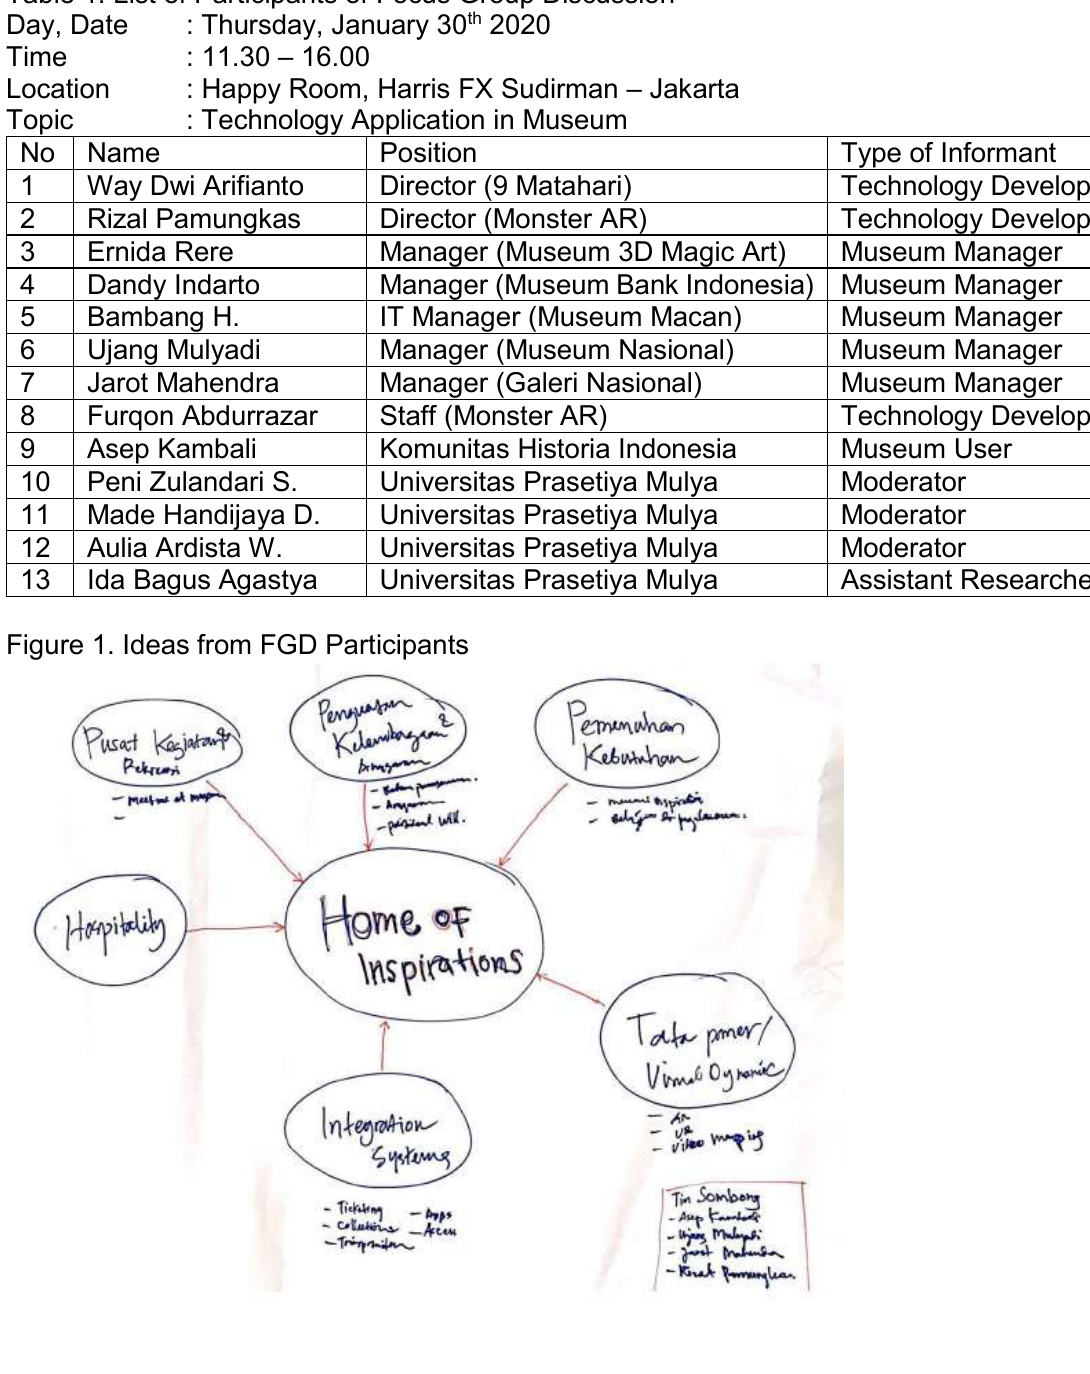
FIGURE AND TABLES Table 1. List of Participants of Focus Group Discussion